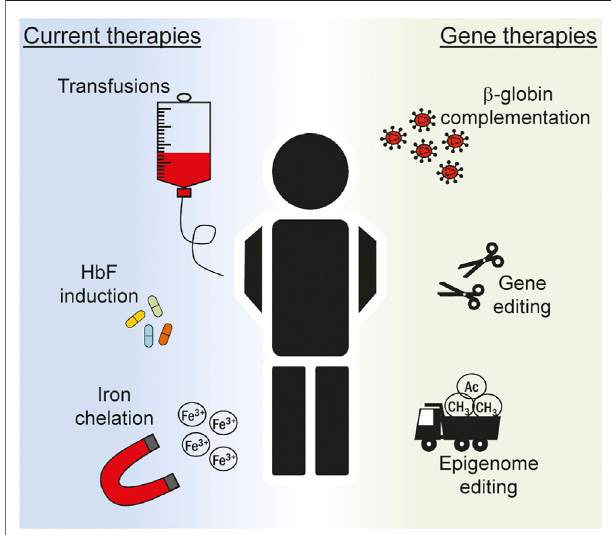
FIGURE 2 | Overview of current treatments for hemoglobinopathies. Multiple strategies are devised to ameliorate the clinical manifestation of hemoglobinopathies in patients. Current treatments (left) include recurrent blood transfusions, pharmacologic induction of fetal hemoglobin (HbF) expression and removal of iron excess. The knowledge acquired on the complex mechanism that regulates globin expression has boosted in recent years the inception of novel gene therapeutics (right). Ex vivo editing of autologous stem cells can be explored to correct the genetic defect and restore normal hematopoiesis. In this context lentiviral vectors expressing the β -globin gene can be used to correct the phenotype of patients suffering from the most severe hemoglobinopathies, such as β -thalassemia and sickle cell disease. More recently, genome and epigenome editing technologies are explored to alter globin gene regulation in order toreactivate HbF tomimic the protective effect of genetic traits typical of hereditary persistence of fetal hemoglobin (HPFH)